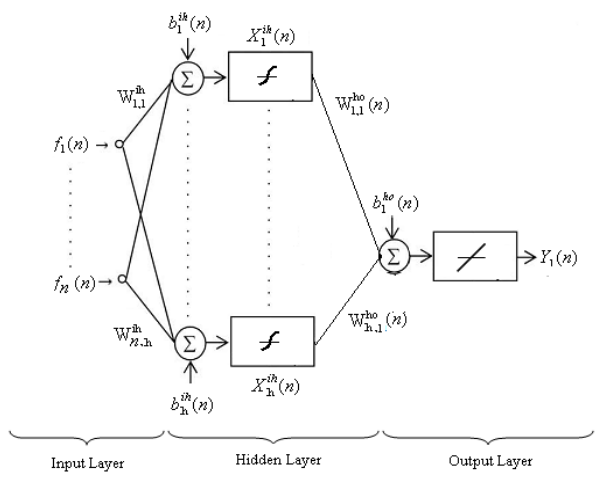
Figure 1 . Implementation of NN-LM for electricity price